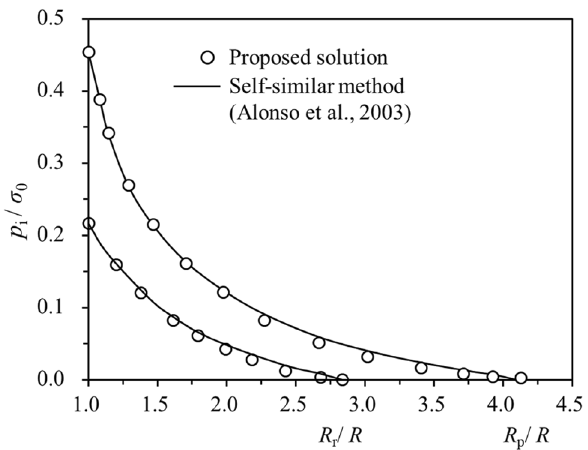
Figure 5. Variations of dimensionless support pressure p i / σ 0 versus plastic radius R r / R 0 , or R p / R 0 for case C5.